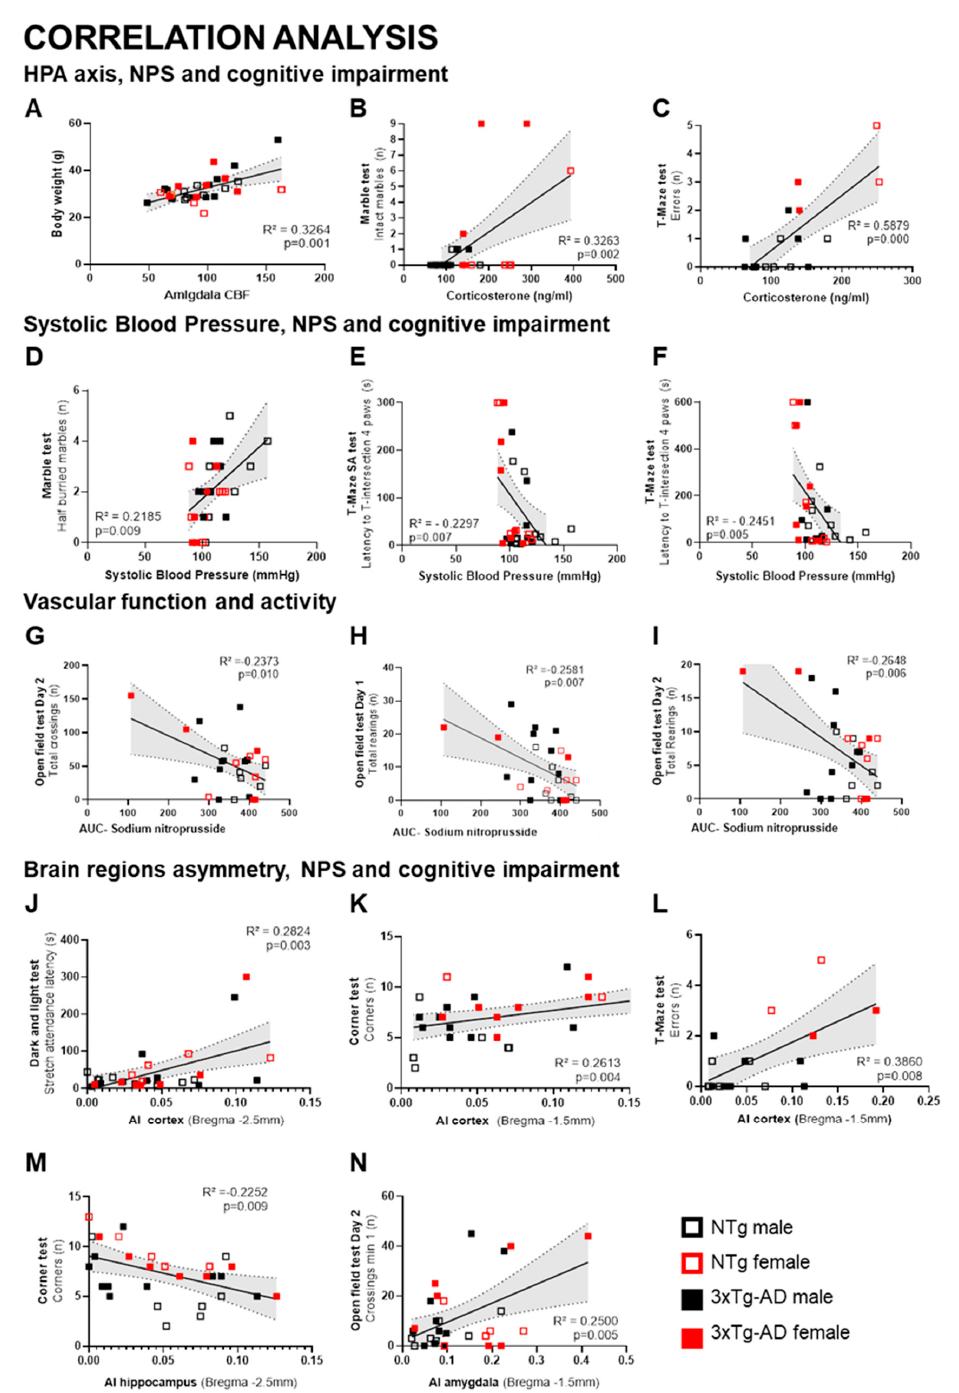
Figure 9. Mental health—cardiovascular function correlation analysis. Meaningful significant Pearson r correlations between behavior and cardiovascular function and HPA axis. ( A ) Amygdala CBF with body weight ( B ) corticosterone levels with the number of intact marbles, and ( C ) errors in the T-maze. ( D ) Systolic blood pressure with the number of half-buried marbles and ( E ) with the latency to arrive to T-intersection with 4 paws in TMSA test and ( F ) TM test. ( G ) Vascular function, as measured by the area under the curve (AUC) of sodium nitroprusside and the total horizontal activity in the first open-field test and ( H , I ) vertical activity in the two open fields. ( J ) Cortical asymmetry index (AI) and risk assessment behavior, ( K ) neophobia in the corner test, and ( L ) errors in the T-maze. ( M ) Hippocampal’s asymmetry index and neophobia in the corner test, ( N ) amygdala’s asymmetry index and neophobia in the second open-field